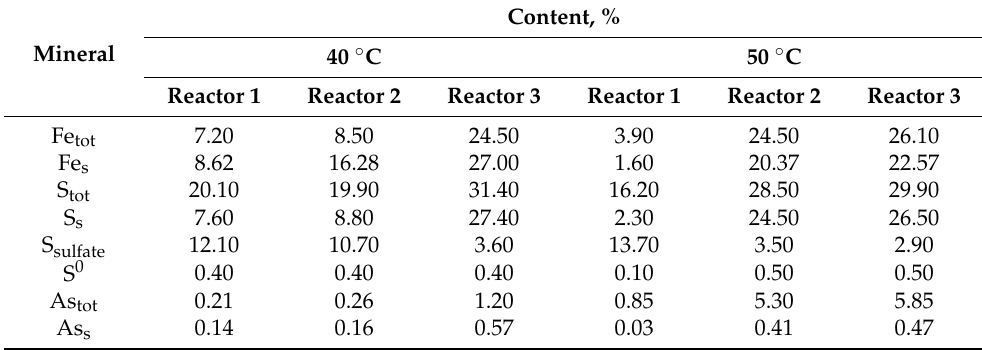
Table 4. Oxidation of sulfide minerals and sulfide sulfur after 40 days of bio-oxidation.